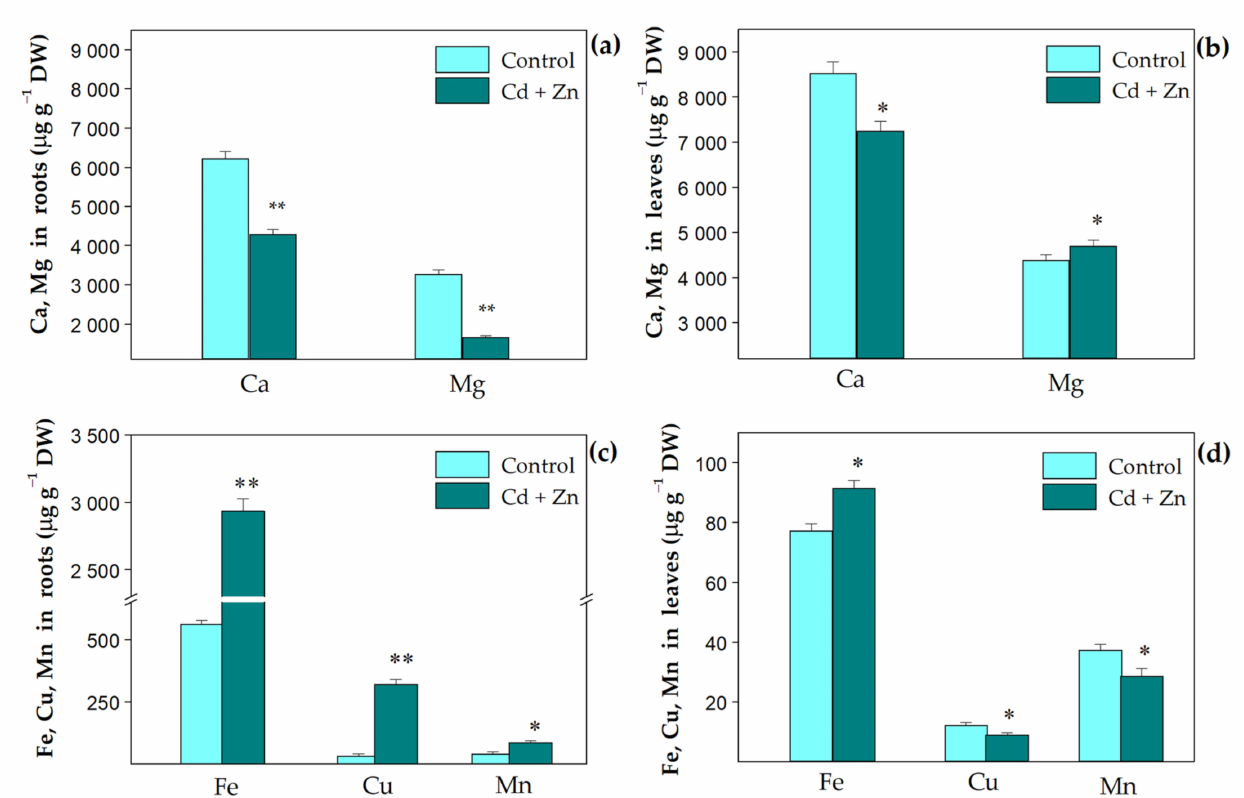
Figure 1. Contents of Ca, Mg ( a , b ), and Fe, Cu, Mn ( c , d ) in Salvia sclarea roots and leaves, respectively, after 8 days of exposure at 100 µ M Cd with and without 900 µ M Zn. Mean values ( ± SD, n = 3) were compared between control and treatment for the same mineral element using a one-way ANOVA, and the differences were considered statistically significant with * p < 0.05 and ** p < 0.01.